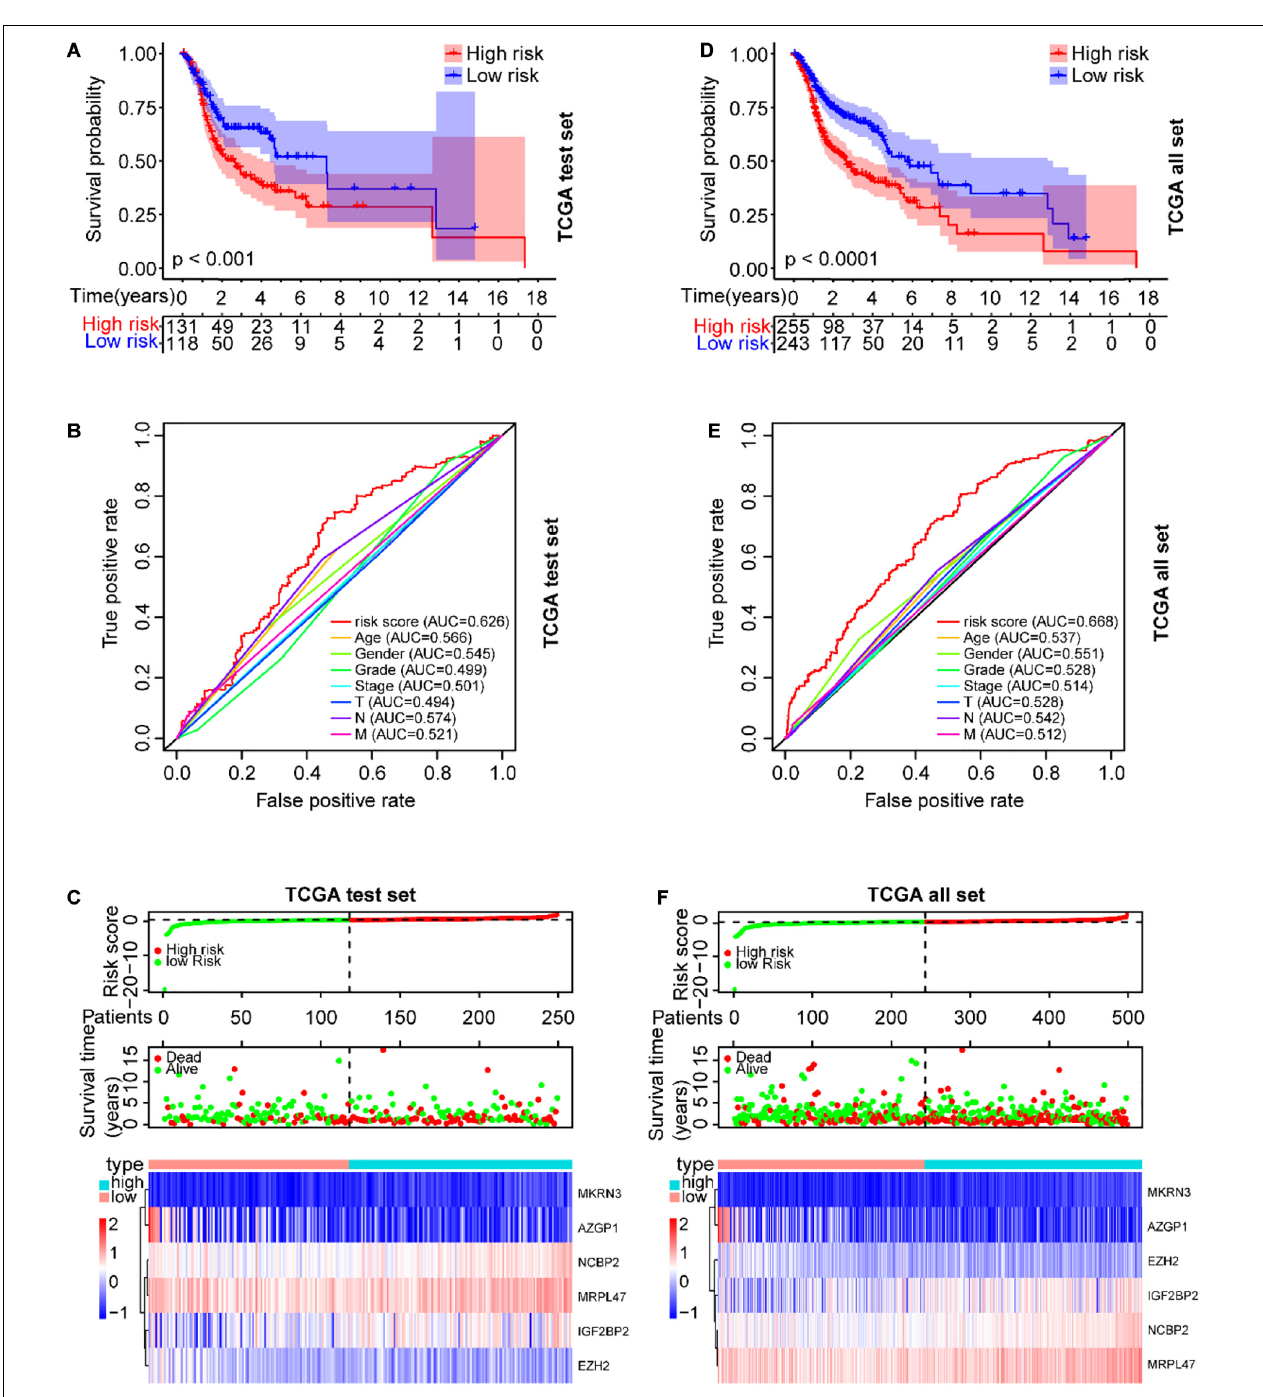
FIGURE 5 | Verification of the prognostic risk model in the TCGA data sets. (A) The OS of SCCHN patients in the risk subgroups showed by the Kaplan–Meier curve in the TCGA test set and the TCGA all set, respectively. (B) The AUC value of risk score and other clinical parameters in the TCGA test set using the ROC curve analysis. (C) The risk plot distribution, survival status, and expression patterns of risk genes of SCCHN patients in the TCGA test set. (D–F) A similar analysis performed in the TCGA data set corresponding to the TCGA test set.